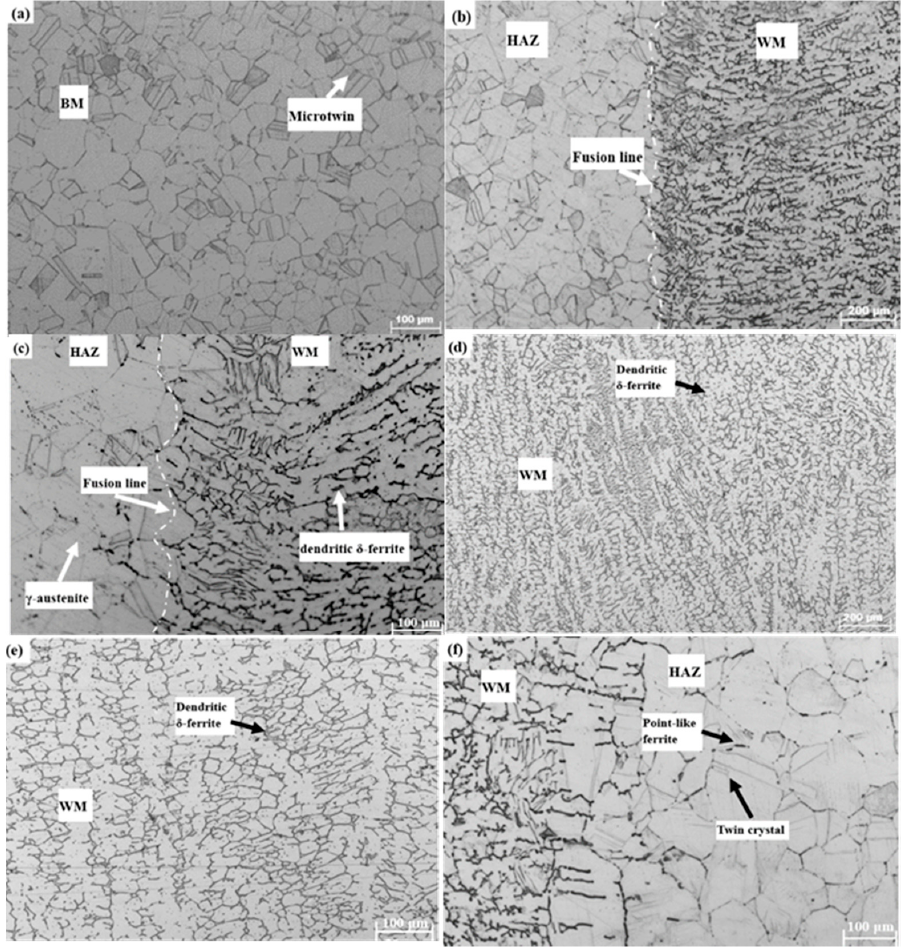
Figure 7. Metallographic structures of weld joints ( a ) the BM; ( b ) the HAZ + BM (100×); ( c ) the HAZ + BM (200×); ( d ) the WM (100×); ( e ) the WM (200×); ( f ) the HAZ.